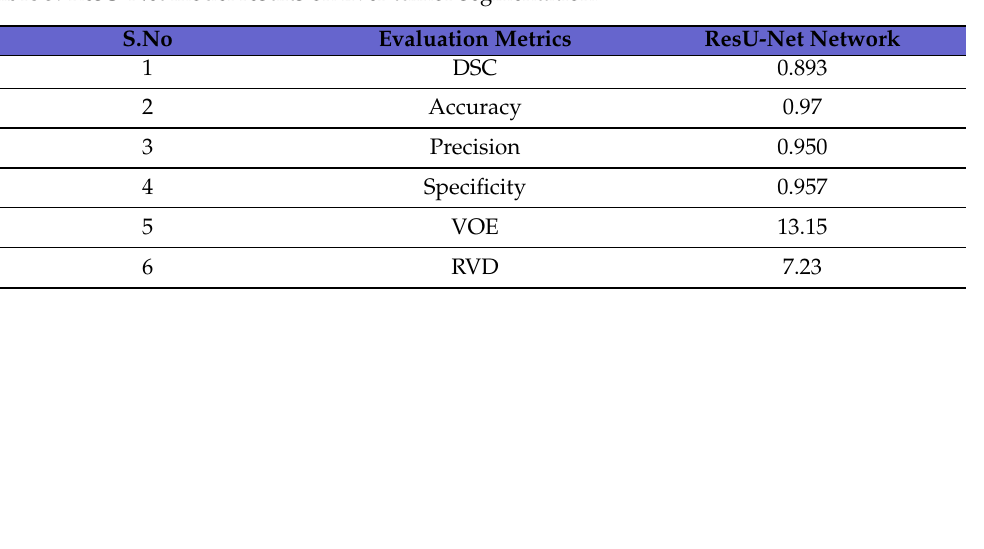
Table 3. ResU-Net model results on liver tumor